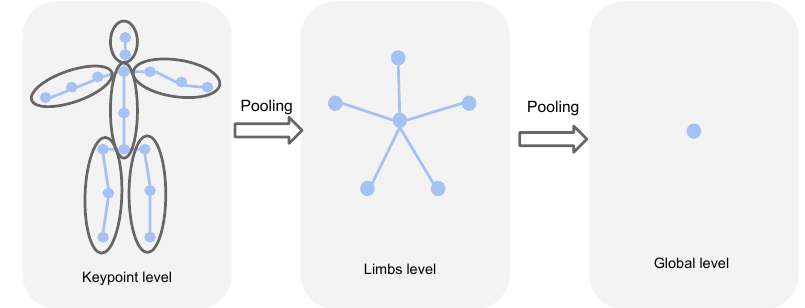
Figure 4. The defined hierarchical graph pooling strategy for the human